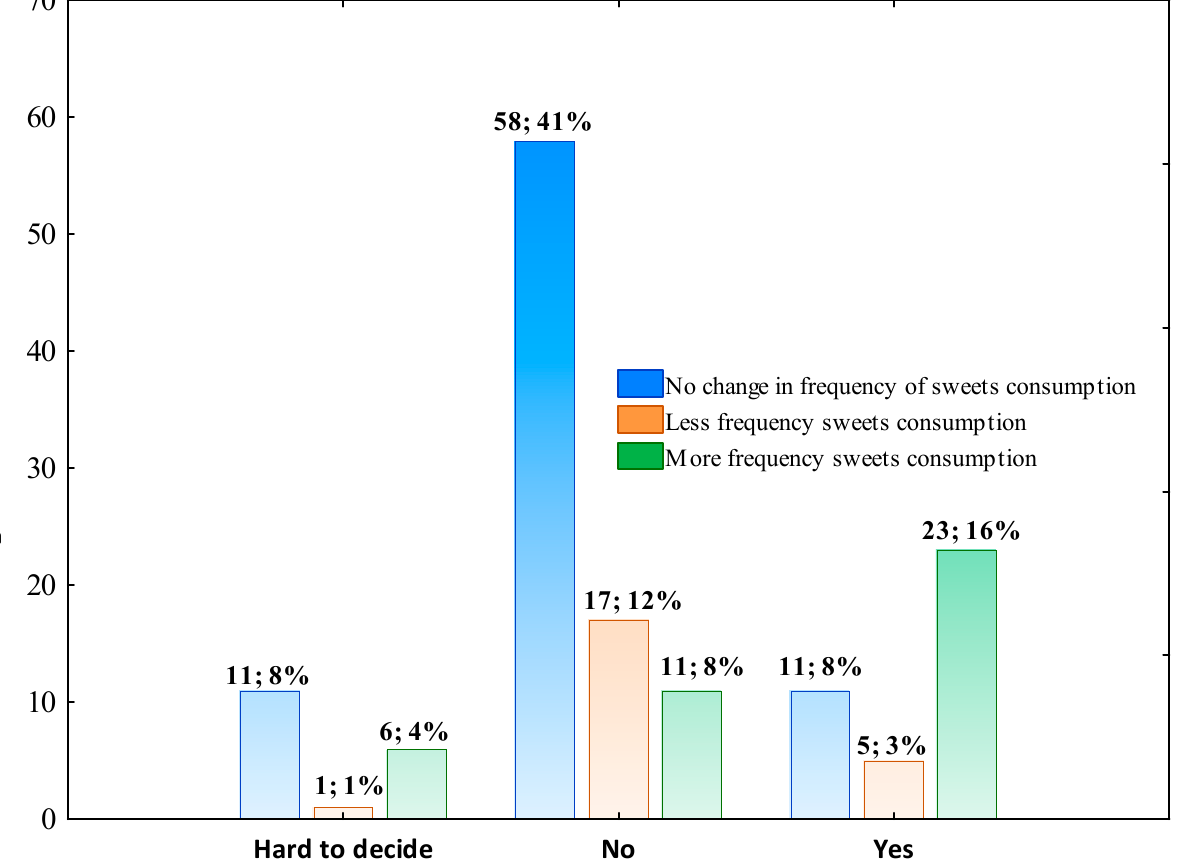
Figure 5. Sweets consumption frequency during the COVID-19 pandemic across respondents de- clared effect or no effect of pandemic on changing the dietary habits. The column description includes the respondents’ number who declared the effect or no effect of the pandemic on changing the dietary habits, followed by the percentage of the total respondents. Data were analyzed using Pearson’s chi-squared test. Pearson’s χ 2 = 30.308; df = 4; p < 0.0000; n = 144.